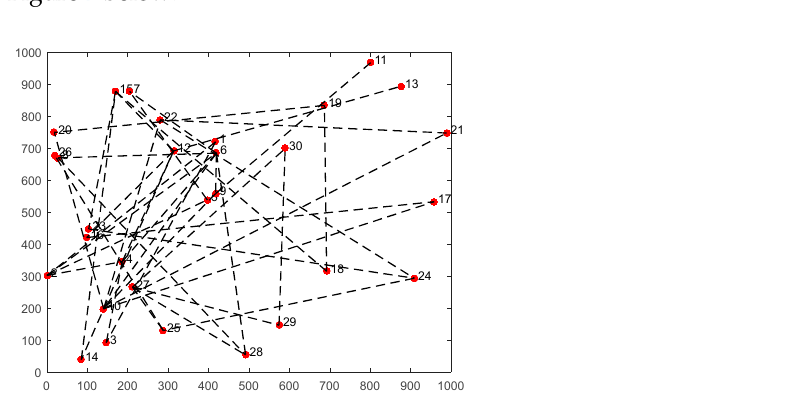
Figure 7. Power-side topology.